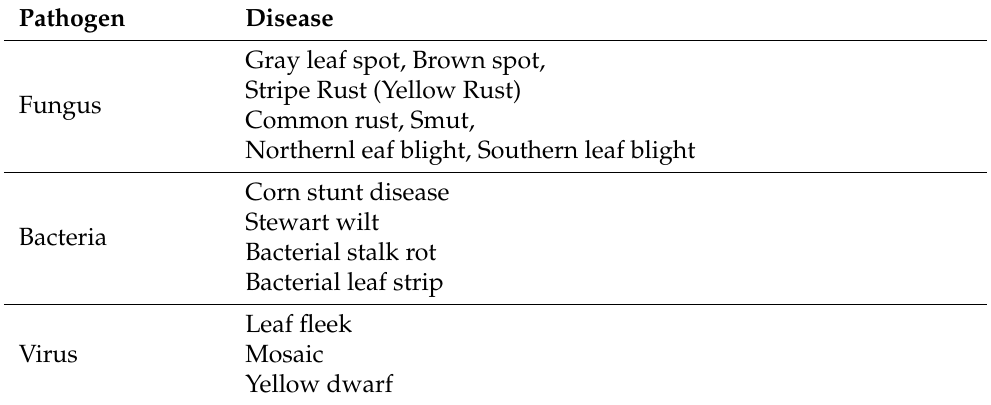
Table 3. Some Maize disease types and causing pathogens [31,33].